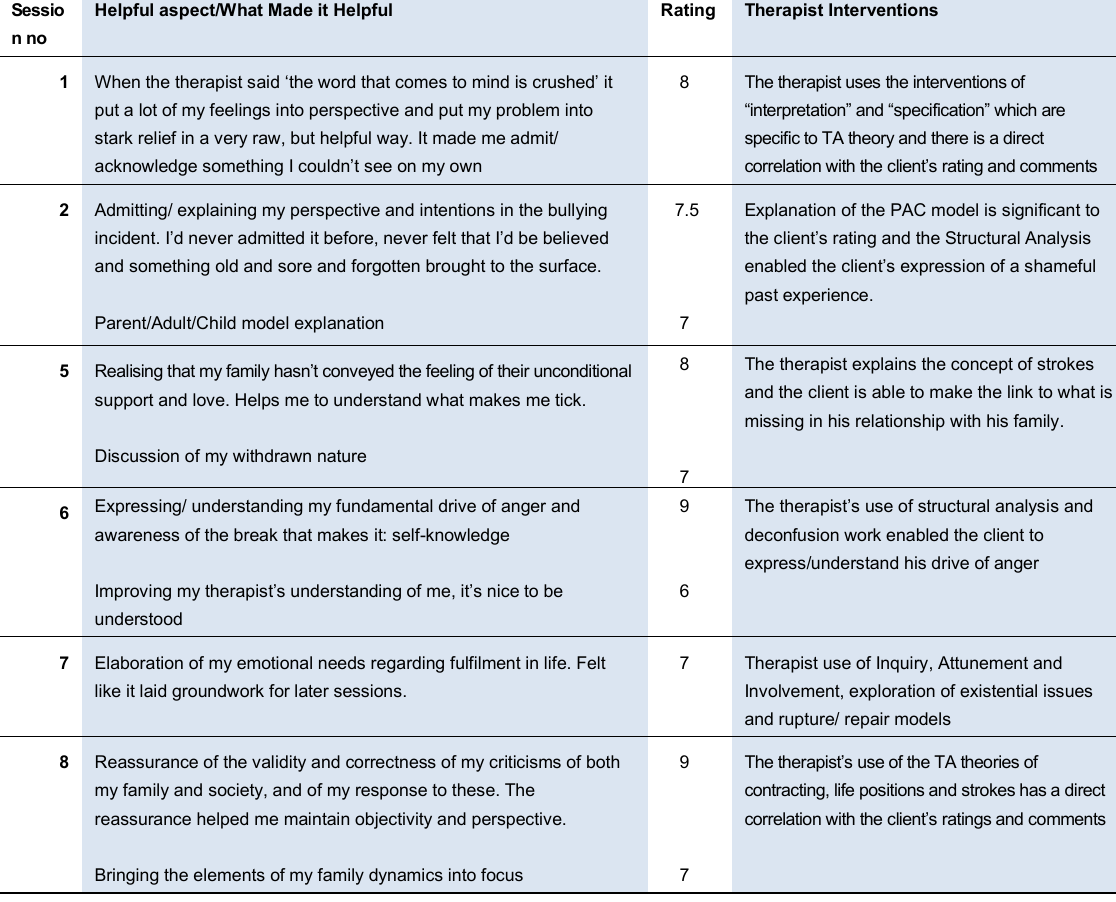
Table B4: Client Comments related to Therapist Interventions Sessio n